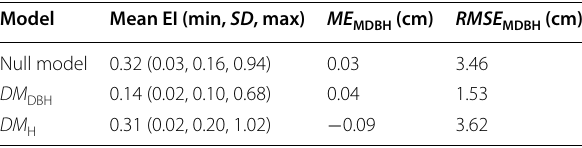
Table 2 Performance assessments of the null model and different distribution matching (DM) setups to predict DBH distributions of decay-affected